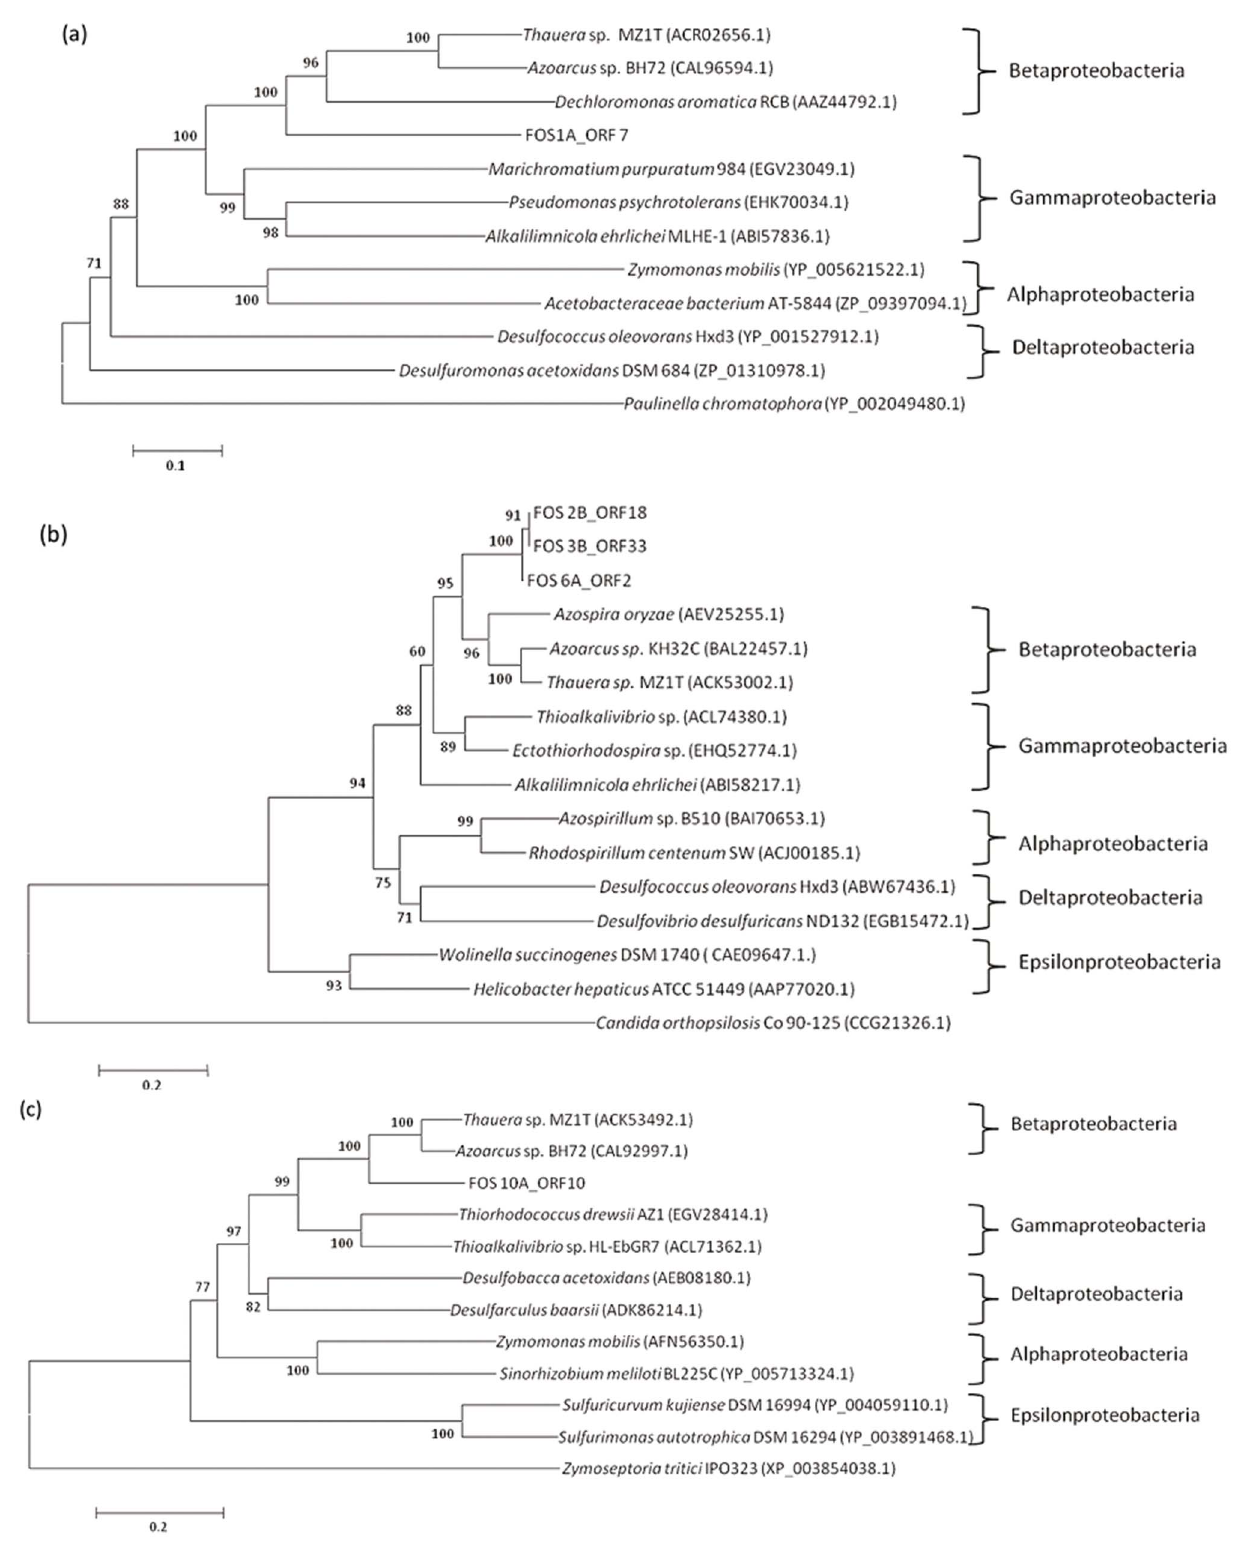
Figure 6. Phylogenetic analysis based on the deduced amino acid sequences of selected proteins in the metagenomic fosmid clones. (a) Primosomal protein N (COG L) of ORF 7 from fosmid clone FOS 1A, (b) ParB protein (COG K) of ORFs 18 from fosmid clone FOS 2B, ORF 33 from FOS 3B and ORF 2 from FOS 6A, and (c) arginine-tRNA ligase (COG J) of ORF 10 from fosmid clone FOS 10A. Bootstrap values (1000 replicate runs, shown as %) are listed. GenBank accession numbers are listed in parentheses after the species names.